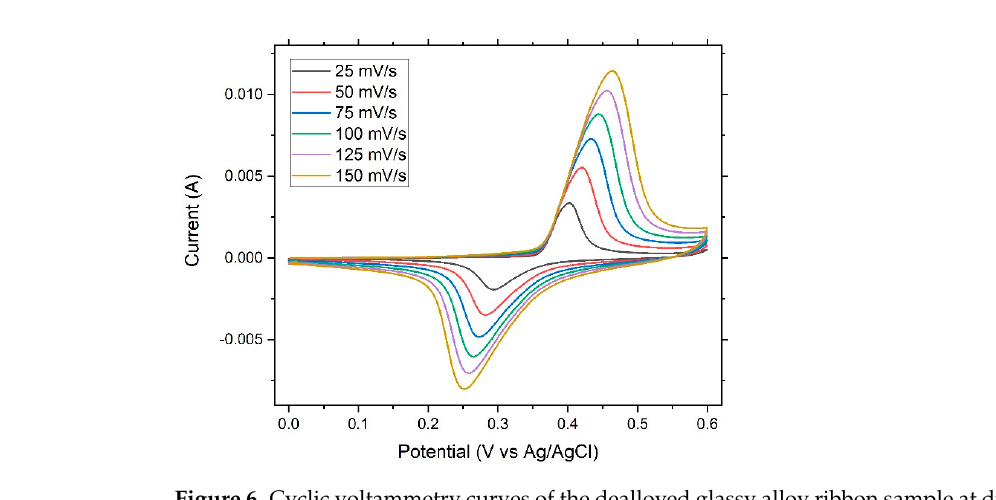
Figure 6. Cyclic voltammetry curves of the dealloyed glassy alloy ribbon sample at different scanning rates, as indicated.